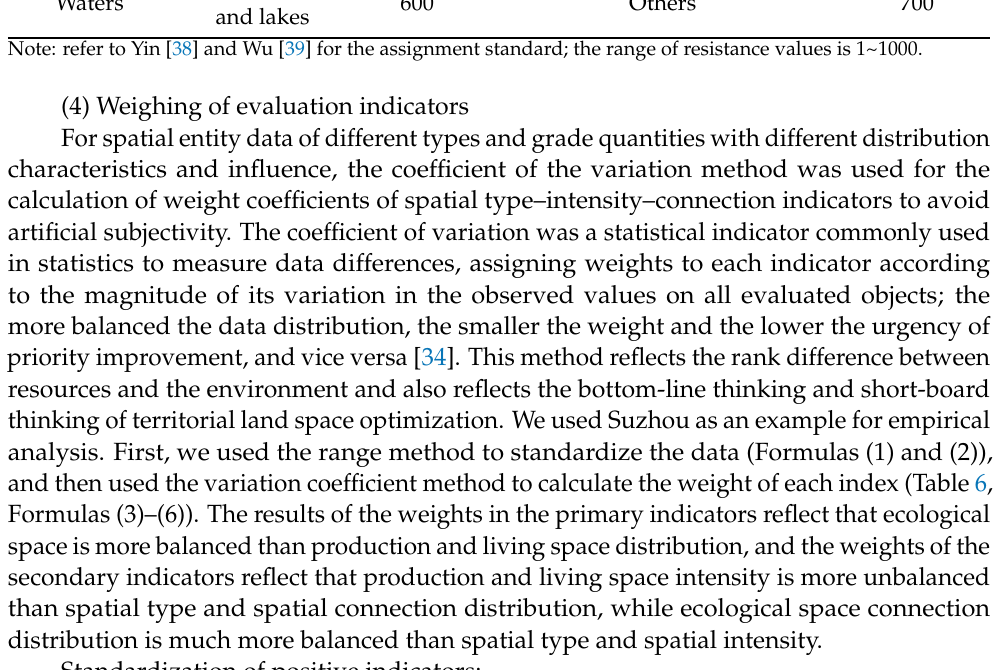
Paddy field Village Farmland